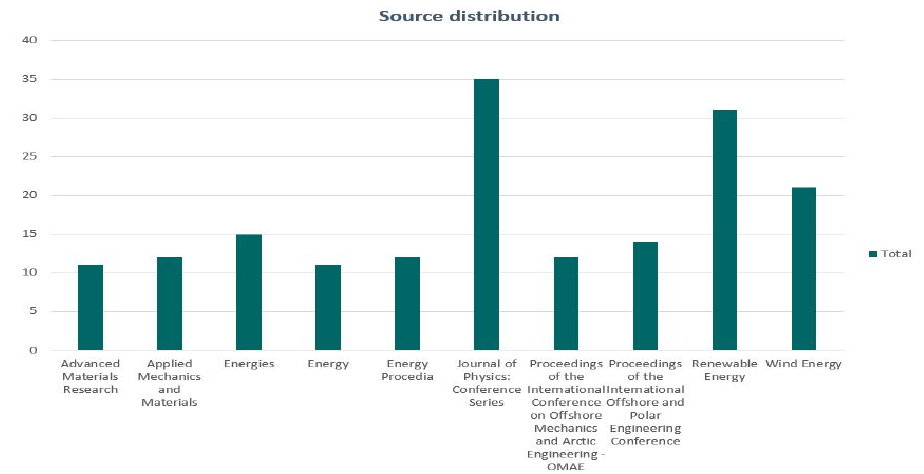
Figure 3. The number of articles extracted from different sources.